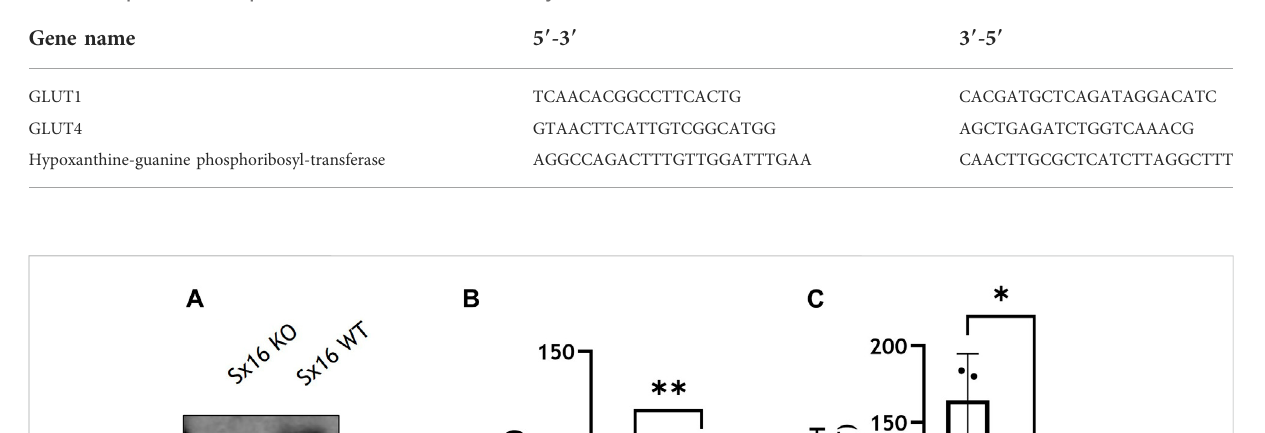
TABLE 1 Sequences of the primers used in Real-Time PCR